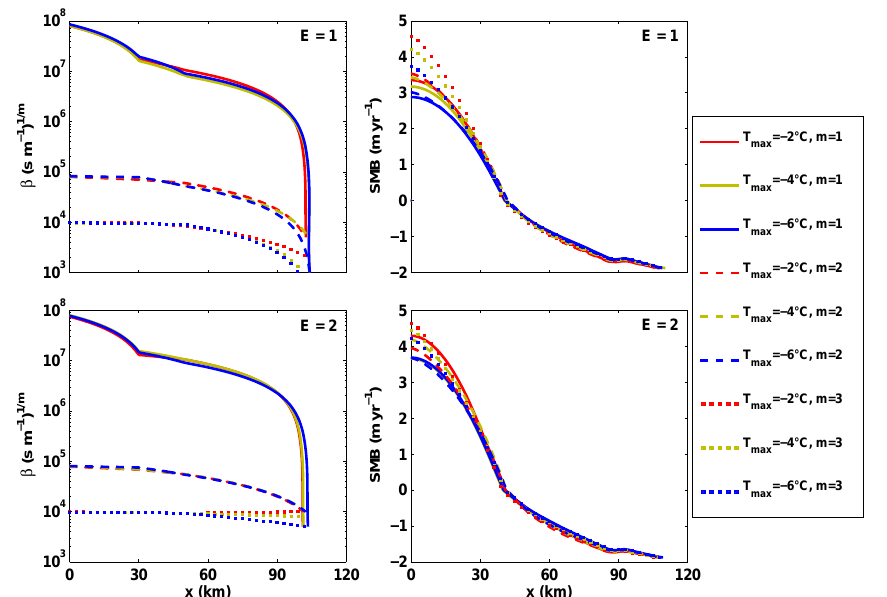
Fig. 2. Profiles of the (left) basal roughness factor, β , and (right) surface mass balance, SMB, for the 18 model simulations performed using the over-deepened bed profile. The basal roughness factor is plotted using a logarithmic scale to highlight the dependence of the chosen piecewise linear functions on m . As in Fig. 1, differences in the maximum ice temperature ( T max ) and basal sliding exponent are distinguished by line color and style,